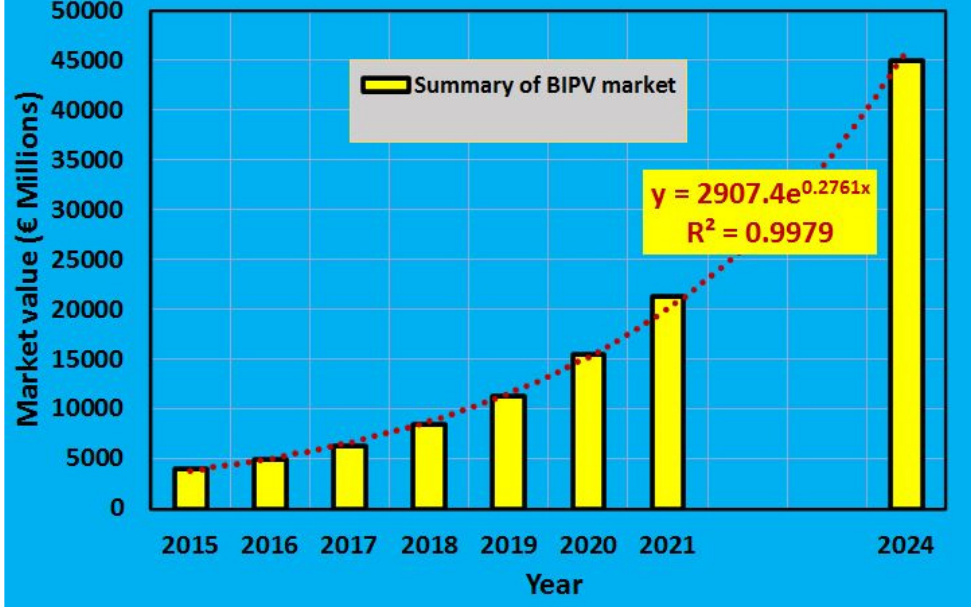
Figure 3. Summary of predicted BIPV technologies’ market shares. This fi gure is reproduced by using the data up to 2021 that is presented in Ref. [50]. The data are digitally extracted and may have some variations from the original presentation. The BIPV technologies market share can be expected to reach above 45000 (€ Millions) if the energy market grows without global disruption.